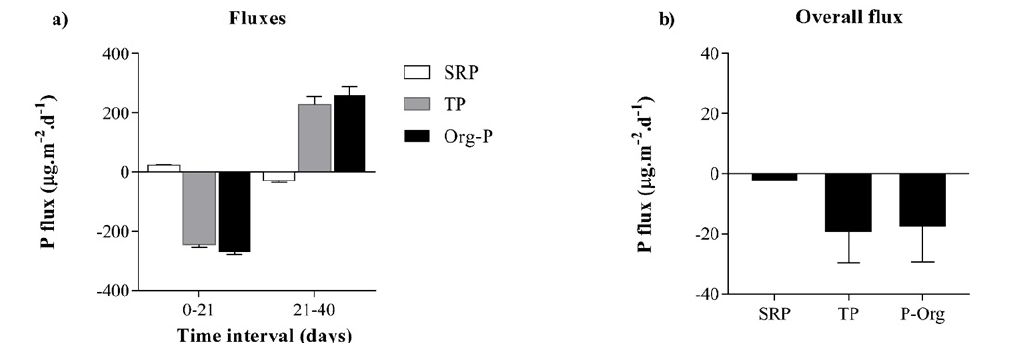
Figure 5. P fluxes between sediment and water throughout the experiment calculated for the intervals between day 0 to day 21, and day 21 to day 40 for SRP, TP, and Org-P (a). Overall P fluxes between the sediment and water (b). Error bars represent the standard deviation. SRP = Soluble reactive phosphorus TP= Total phosphorus Org-P = Organic